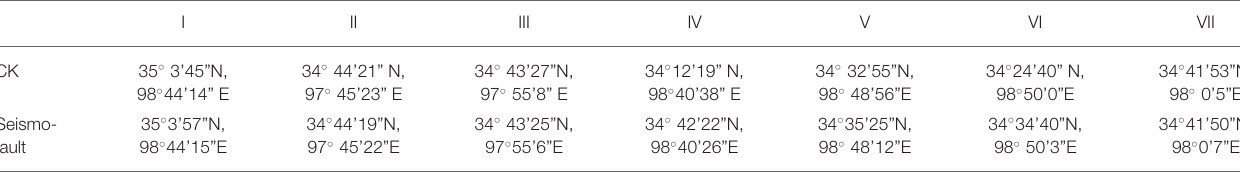
TABLE 1 | The location of the sample points.